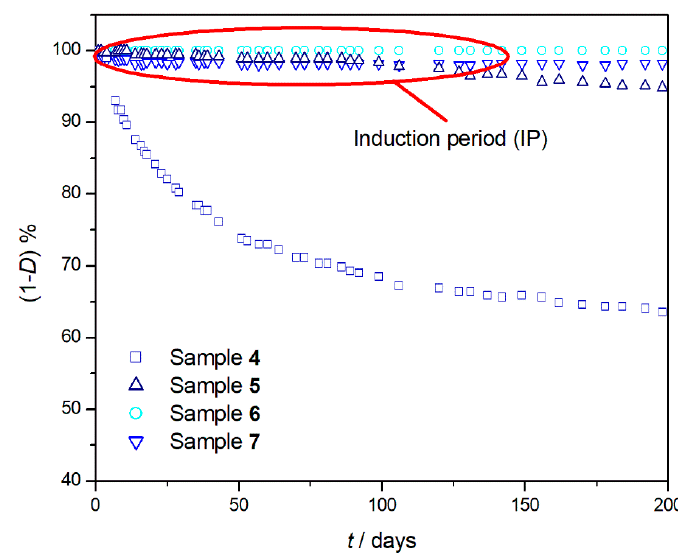
Figure 2. Percentage of undegraded sample (1 − D )%, at 150 °C as a function of heating time ( t ) for PE (sample 4 ), PS (sample 5 ), PC (sample 6 ), and PMMA (sample 7 σ ) after 200 days of degradation.